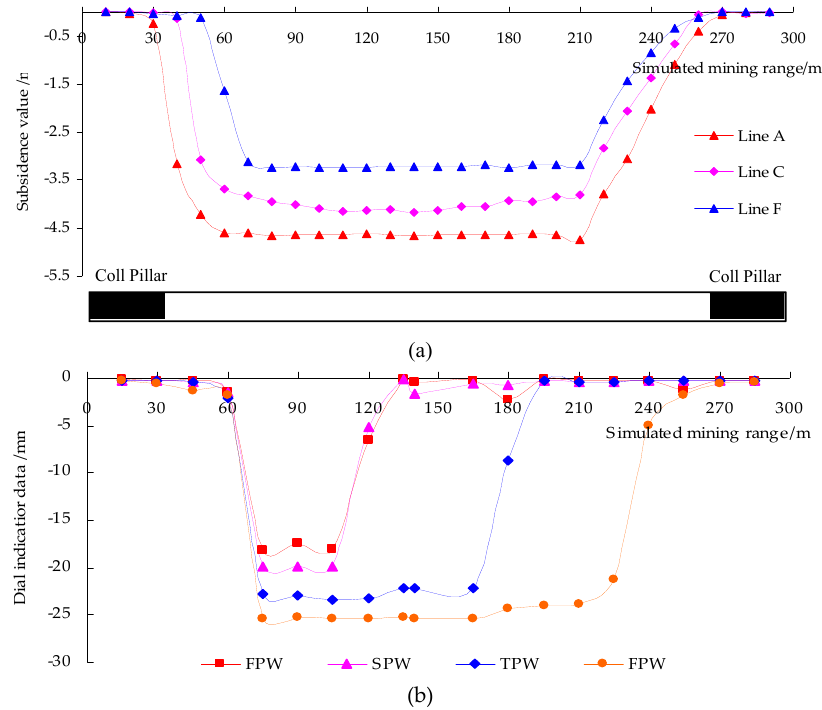
Figure 28. Subsidence curve of bedrock and surface: (a) subsidence curve of line A, line C and line F; (b) subsidence curve of surface.